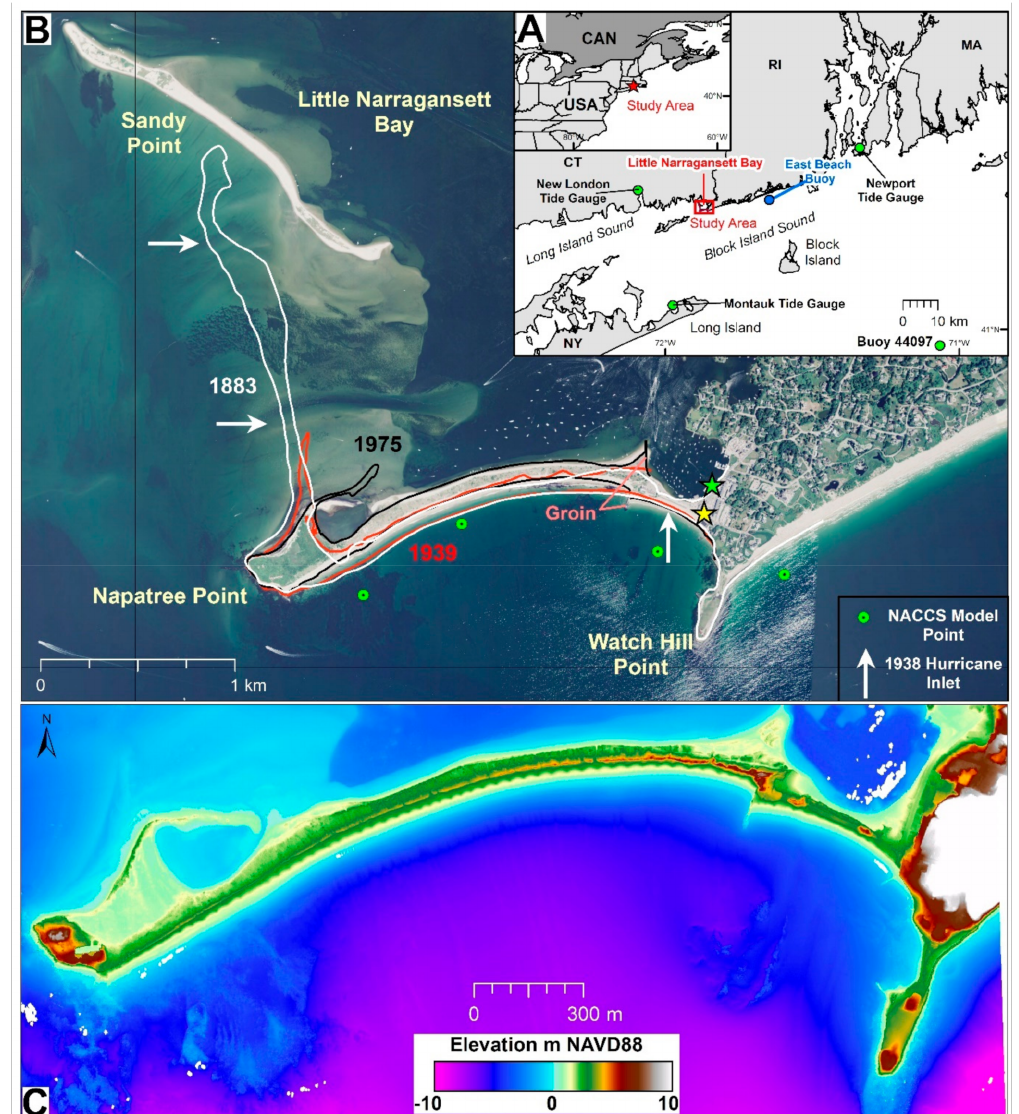
Figure 1. ( A ). Location map of Napatree Point. ( B ). A 2014 Digital orthophotograph [22] with past shoreline positions superimposed in 1883 (white), 1939 (red) and 1975 (black) [23–25]. Note that Sandy Point was connected to Napatree Point in 1883 but has migrated north since the 1938 hurricane. White arrows indicate the 1938 hurricane [26]. The yellow star shows the location that the photograph in Figure 5D was captured at. Green circles indicate the locations of the NACCS buoys discussed in the text. The green star shows the location of the U.S. Geological Survey water level gauge. ( C ). A 2018 LiDAR Topobathymetric model of Napatree point and the adjacent Watch Hill, elevation in meters above NAVD88